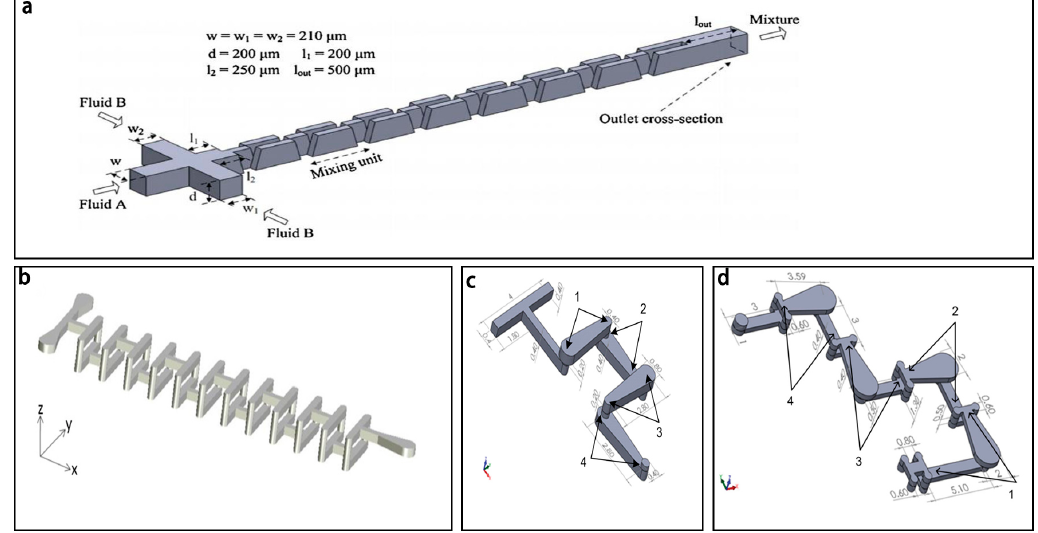
Figure 18. ( a ) Schematic of the chamber based micromixer with shifted trapezoidal chambers; ( b ) Schematic of the H micromixer; ( c ) Schematic of the chain micromixer; ( d ) Schematic of the H-C micromixer. Reproduced with permission from [111,144].